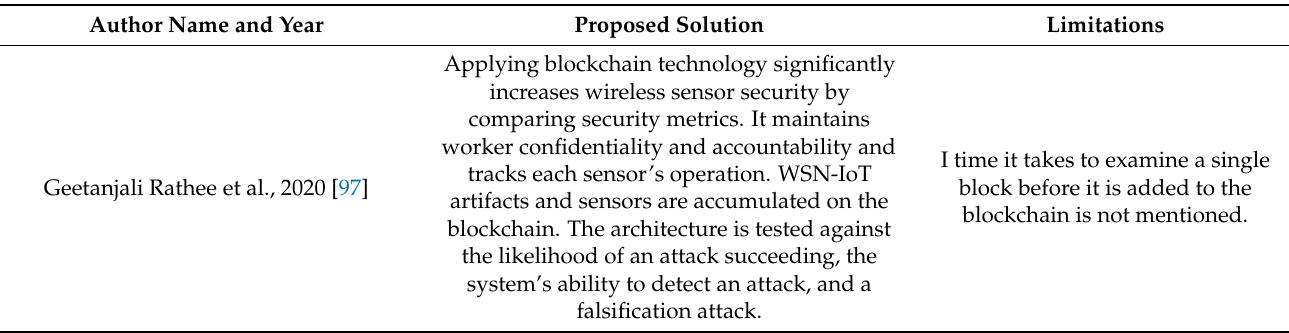
Table 4. WSN-IoT security mechanism solutions and their